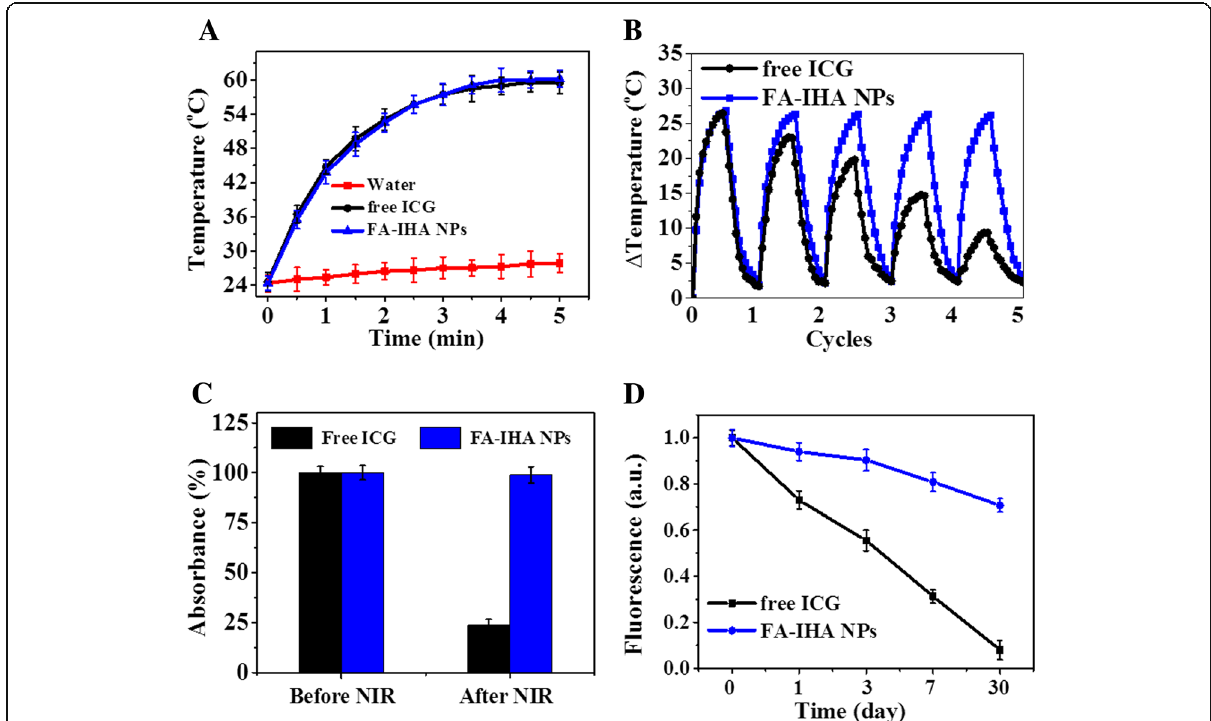
Fig. 3 a Photothermal heating curves of water, ICG, and FA-IHA NPs under 5 min 808 nm laser irradiation (1 W/cm 2 ). b Temperature variations of ICG and FA-IHA NPs after continuous 5 min of irradiation with an 808 nm laser for 5 cycles. c The absorption change of FA-IHA NPs at 780 nm before and after irradiation with an 808 nm NIR laser for 5 cycles. d ICG and FA-IHA NPs fluorescence change over 30